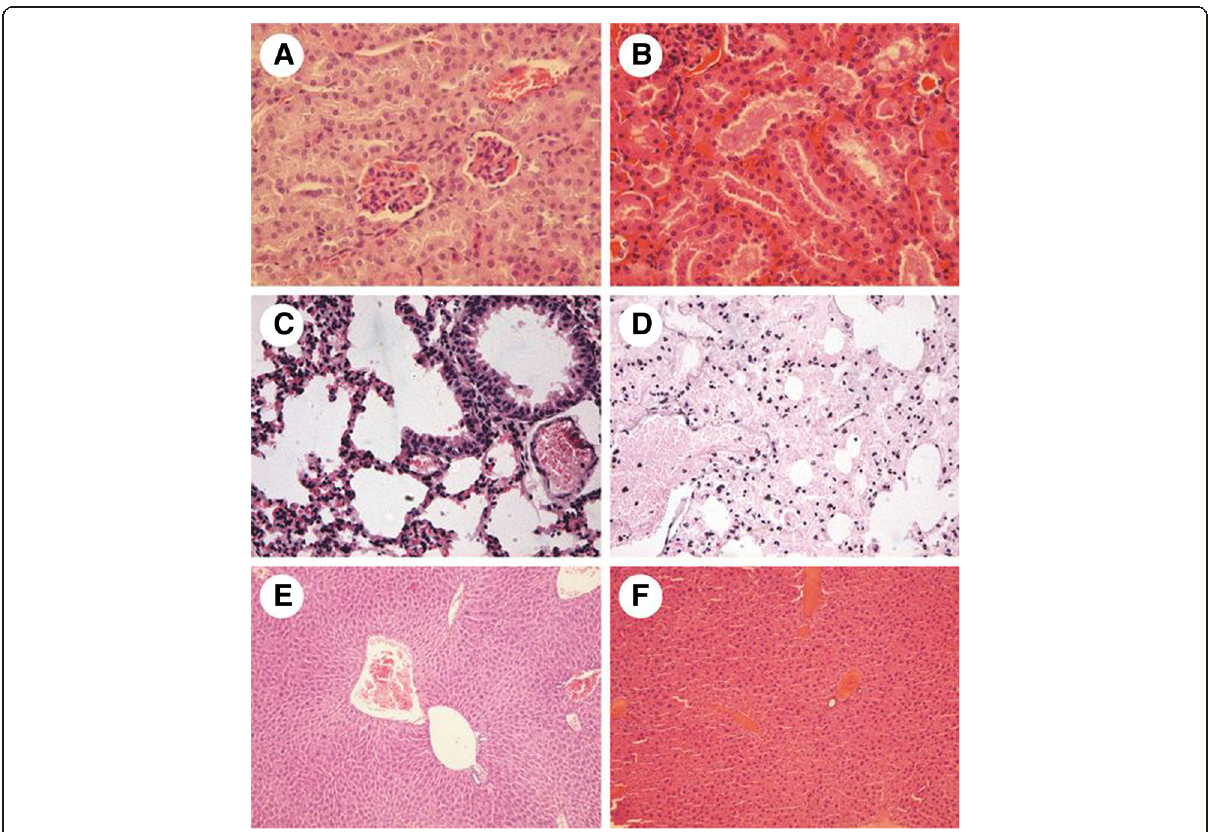
Fig. 5 Light micrographs of tissues sections after the administration the M. alcicornis aqueous extract by intravenous route. a Control kidney section compared with a ( b ) kidney section of mice previously administrated with the extract, note severe peritubular capillary congestion. c Control lung section compared with a ( d ) lung section of mice previously administrated with the extract, note alveolar membrane thickening and hemorrhagic zones. e Control liver section compared with a ( f ) liver section of mice previously administrated with the extract, note acute vascular congestion and areas with fibrinoid material. a , b , c and d : 400× magnification. e and f : 100× magnification. Hematoxylin-eosin